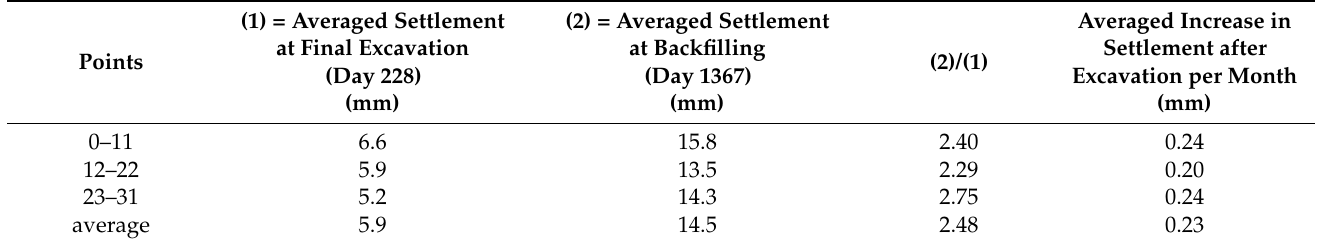
Table 2. Comparison of settlement of top of retaining wall at final excavation and backfilling.